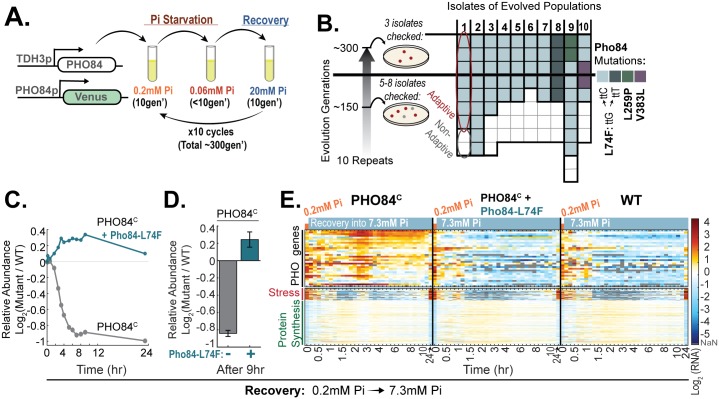
Lab evolution selects for PHO84 mutations that rescue the recovery phenotype of PHO84C.(A) Experimental scheme: 16 independent lines expressing constitutively high levels of PHO84 were subjected to 10 cycles of alternated growth in high and low phosphate for a total of 300 generations. (B) PHO84 mutations identified in selected lines: Single-cell isolates (evolved for approximately 150 and approximately 300 generations) were selected from the 10 cultures showing improved recovery and were sent for whole-genome sequencing. All isolates showing an adaptive phenotype contained mutations in the Pho84 open reading frame (ORF), with 56 out of the 60 identified mutations mapped to the same amino-acid substitution (L74F). (C–E) Selected PHO84 mutation rescues the recovery phenotype: The PHO84 mutations identified in the selected stains were introduced into the wild-type allele and their effect on the growth in low Pi and on the recovery phenotype was examined when PHO84 was expressed at wild-type levels or constitutively (both the constitutive overexpression and the evolved mutations were introduced into PHO84 endogenous site). Shown is the recovery of the constitutive strain with and without the amino-acid substitution (Pho84-L74F(ttG/ttC)) following 24.7 hours incubation in 0.2 mM Pi (C, D) and the corresponding pho4-target gene expression during recovery (E). Note the rescue of the recovery phenotype and the immediate down-regulation of pho4-target genes. See S6B–SBJ Fig for the growth in low-phosphate media and recovery phenotypes of the selected mutations: Pho84-L74F(ttG/ttC), Pho84-L259P, and Pho84-V383L. The data in (C) are from 1 replicate; see (D) for additional supporting data. The data in (D) are the mean and standard error of 3 replicates. The data in (E) are from 1 replicate. Additional data as in (E) for recovery (from 0.06 mM Pi) are found in S6E Fig. The conclusions of (E) are further supported by experiments with the Venus reporter (see S4 Data). The raw data for (C–D) are available in S4 Data. The raw data for (E) are available in S2 Data. Gen, generations; NaN, not a number; Pi, inorganic phosphate; WT, wild type.